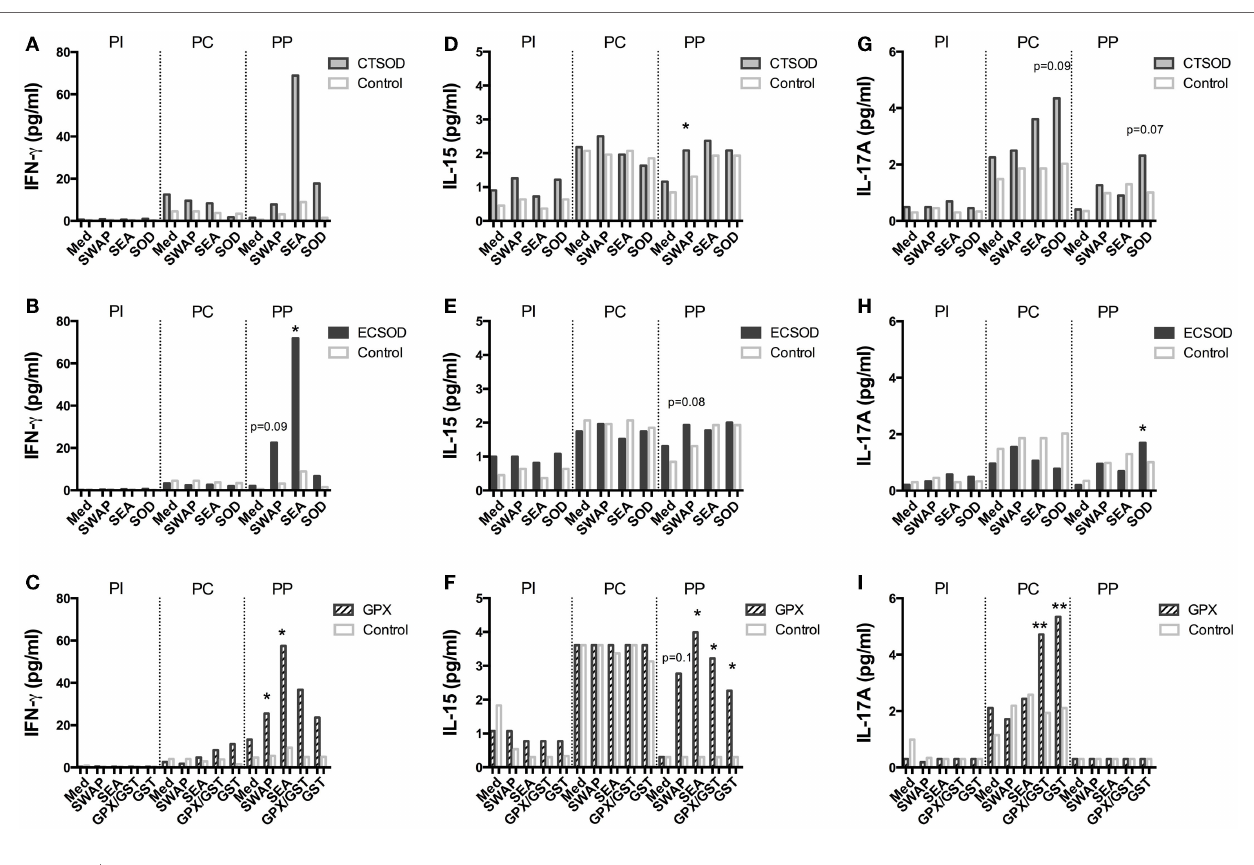
expressed as median of cytokine secretion in five individual supernatants in relation to the Control baboons. Non-parametric (Kruskal–Wallis, Mann– Whitney) tests were applied. Values were considered statistically significant when p < 0.05, and assigned * p = 0.01–0.05; ** p = 0.001–0.01; and *** p = <